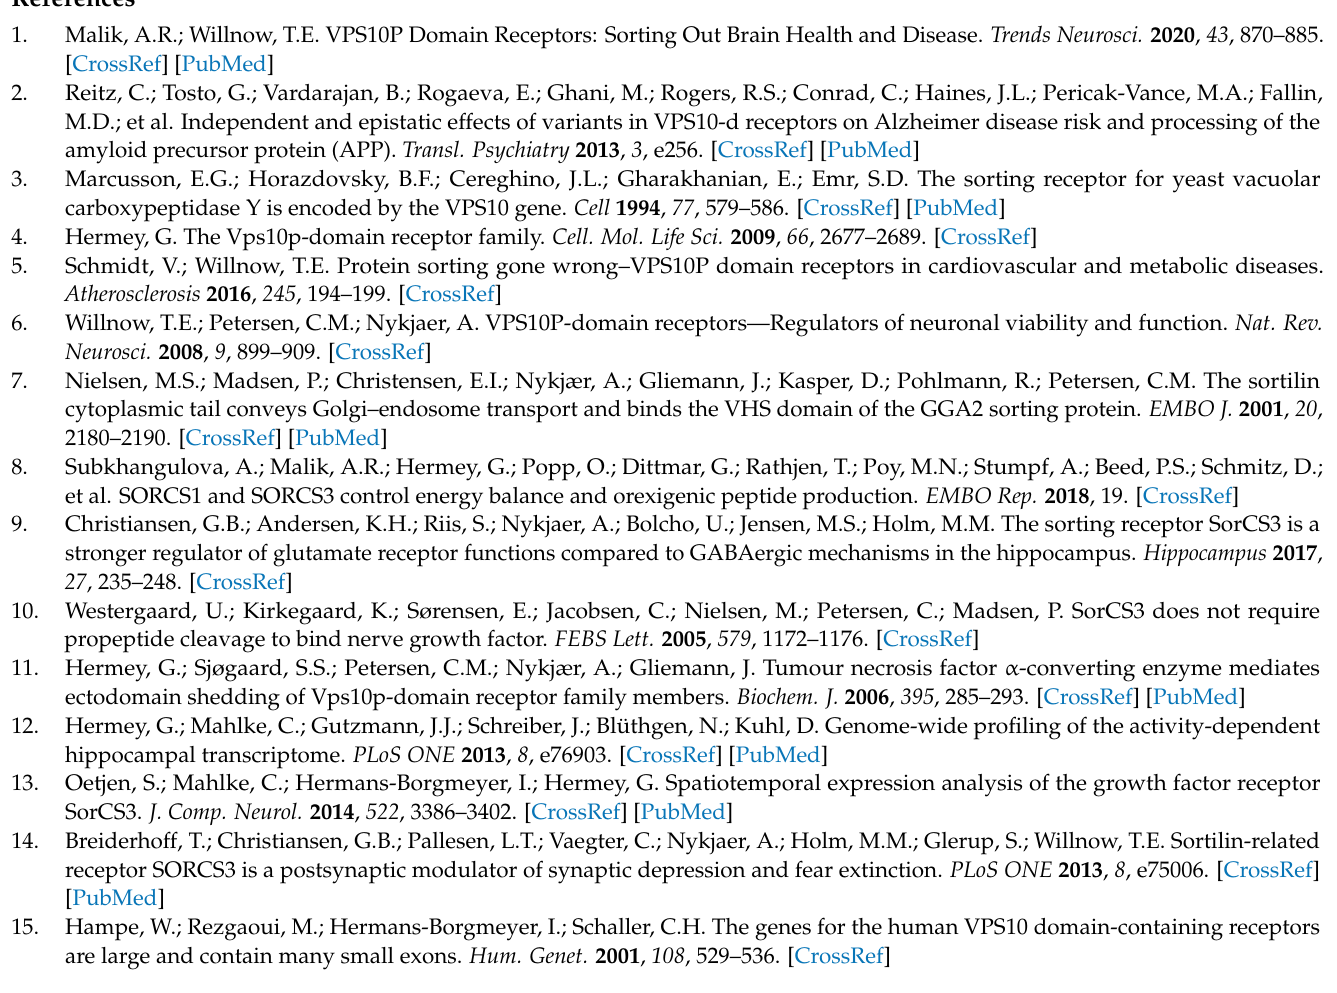
GWAS data, Table S2: SORCS3 gene-set, Table S3: Stratified Linkage Disequilibrium Score Regression (sLDSC) full results, Table S4: Genes within the SORCS3 gene-set that were associated at genome-wide significant levels with BPD, EA, IQ or